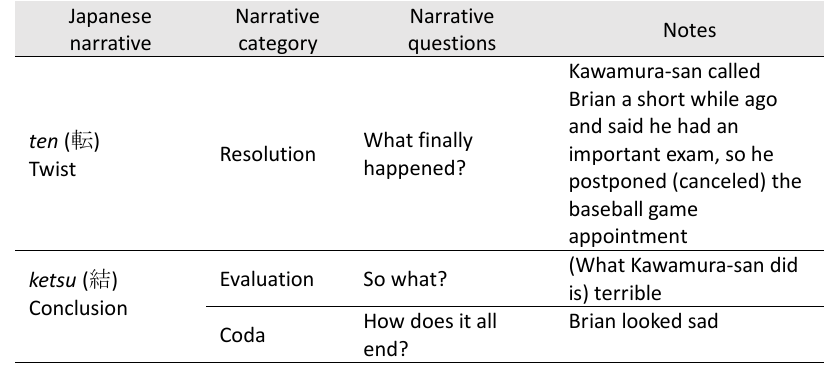
Table 4. Notes for narrative production about the dialogue from NihonGO NOW! ACT 10 Scene 1